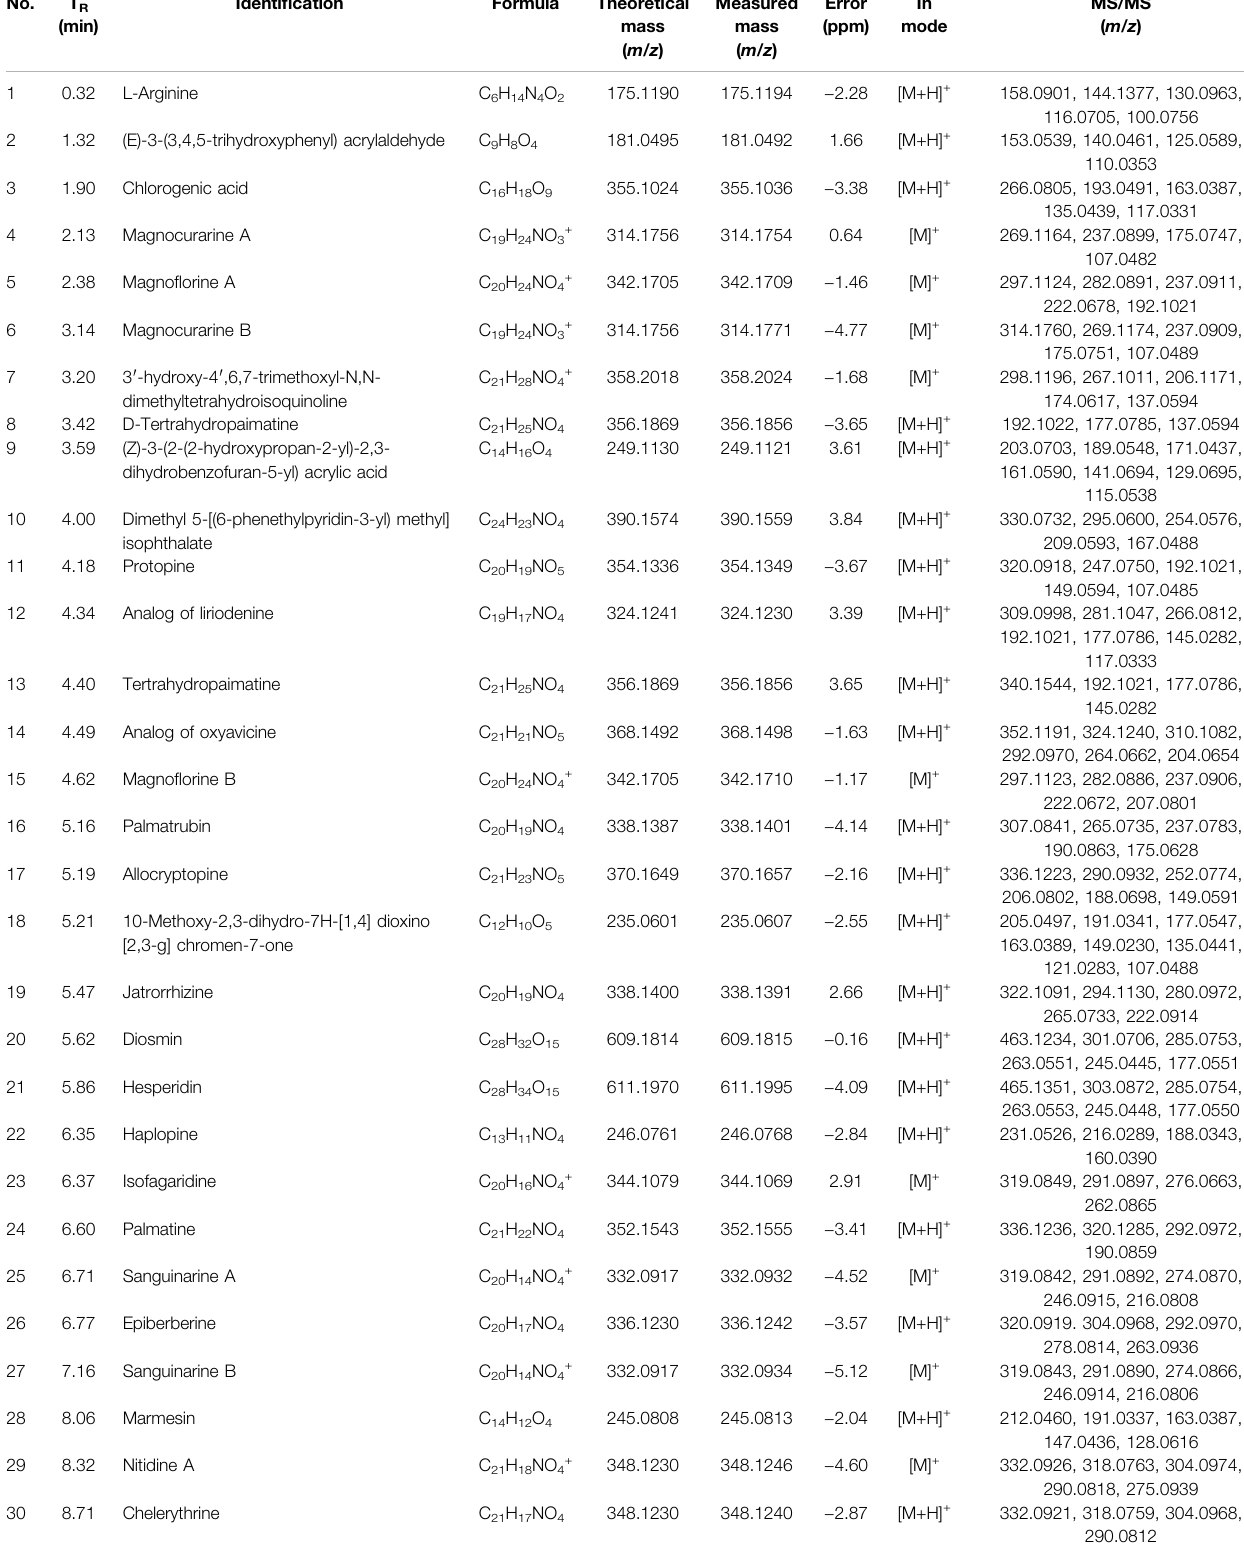
TABLE 1 | Characterization of chemical constituents of Zanthoxylum nitidum (Roxb.) DC. (ZN)